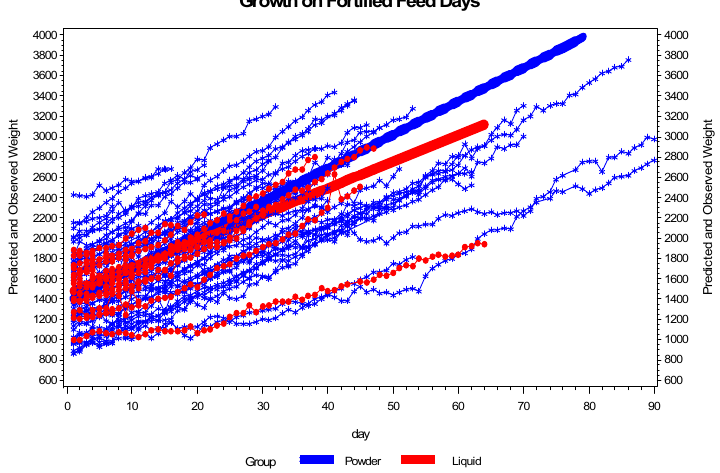
of infants receiving liquid on fortified feed days. The plot shows the growth pattern for each infant and the fitted line by group. Based on the plot, infants on powder grow at a faster rate than infants receiving liquid. Evaluation of growth in gm/kg/day for the days infants were fed fortified breast milk, based on the mixed effects model, shows a significant interaction between day and group ( p = 0.0022). Truncating the analysis at 45 days did not attenuate the